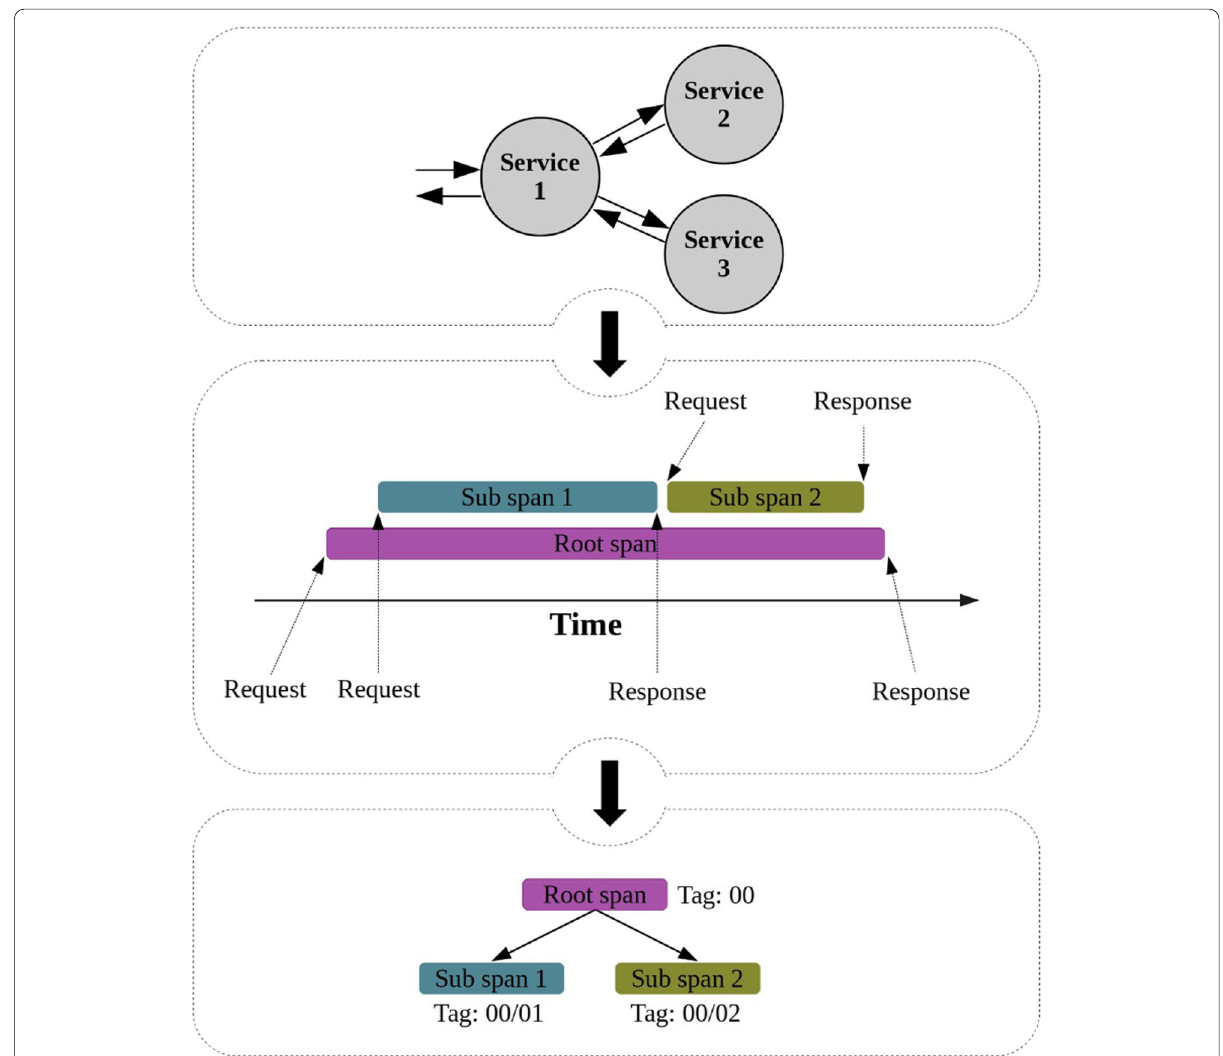
Fig. 4 The structure of a span and its sub-spans in a distributed